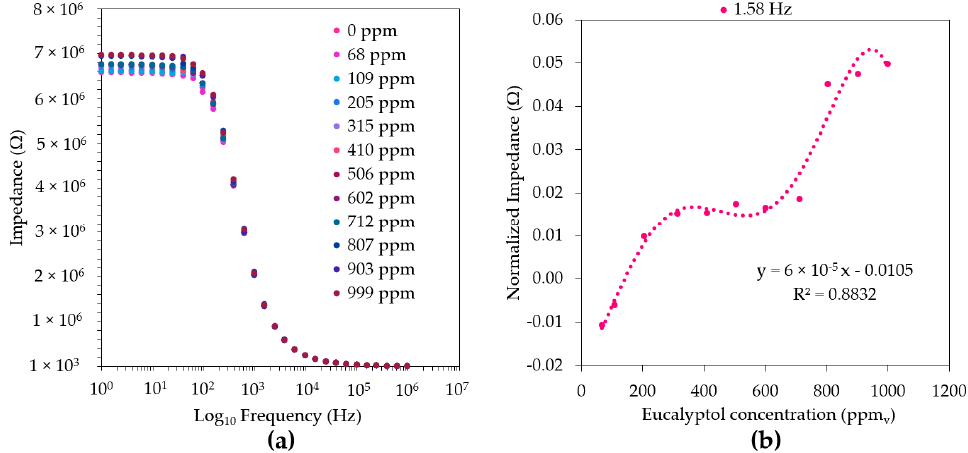
Figure 3. Impedance spectra of the TiO 2 (100% O 2 )-film-based sensor ( a ) and its normalized impedance ( Ω ) spectra at a fixed frequency (1.58 Hz) for different eucalyptol concentrations in air ( b ). The dotted line is only a guideline. The average and standard deviations of the respective impedance data of the duplicates were used for the normalization (Supplementary Materials, Table S8).